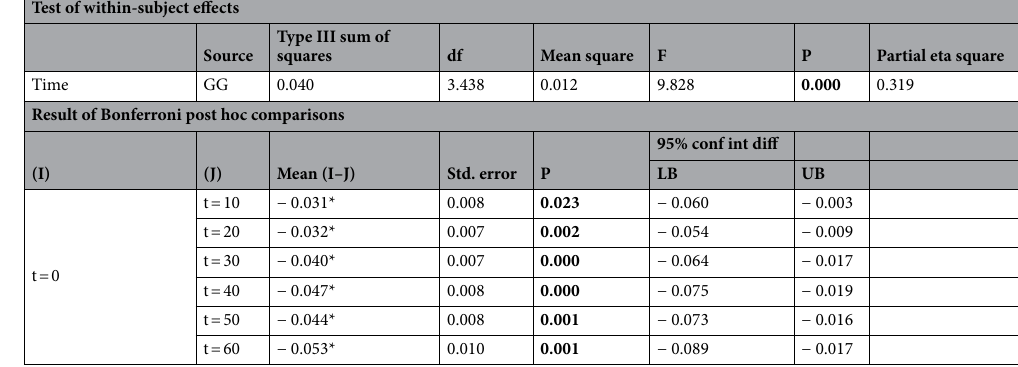
Table 3. Results of repeated measures one-way ANOVA test with Bonferroni post-hoc comparisons. LB lower bound, UP upper bound.